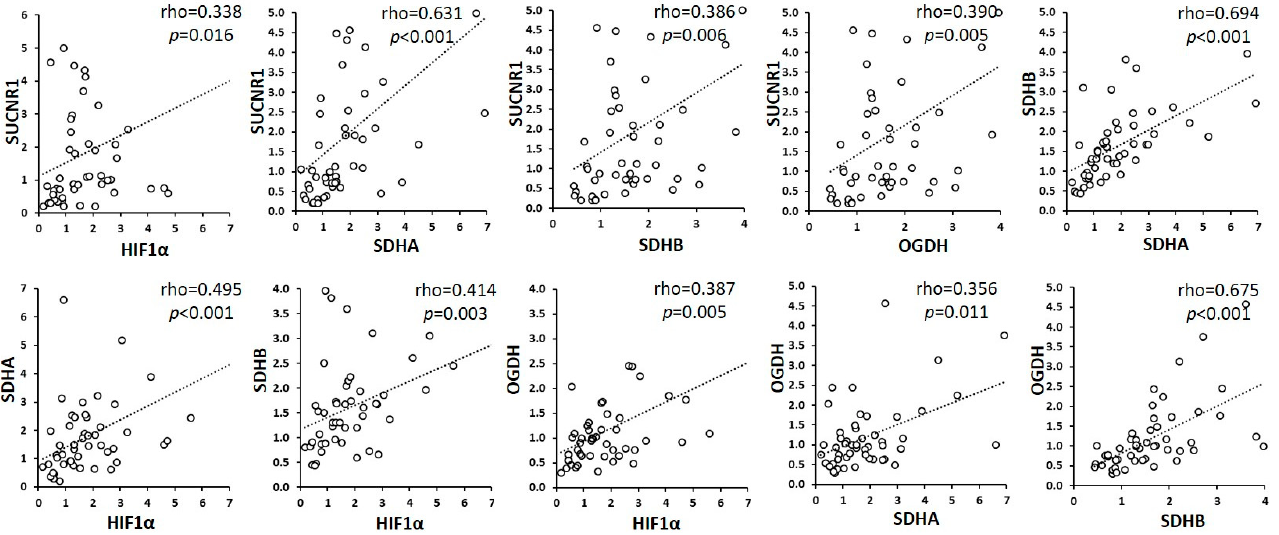
Figure 3. Correlations between HIF-1 α , SDHA, SDHB, OGDH and SUCNR1 expression in tumors. Associations between variables were calculated using Spearman’s rank-order correlation test for nonparametric values. Rho coefficients were considered statistically significant at p < 0.05.